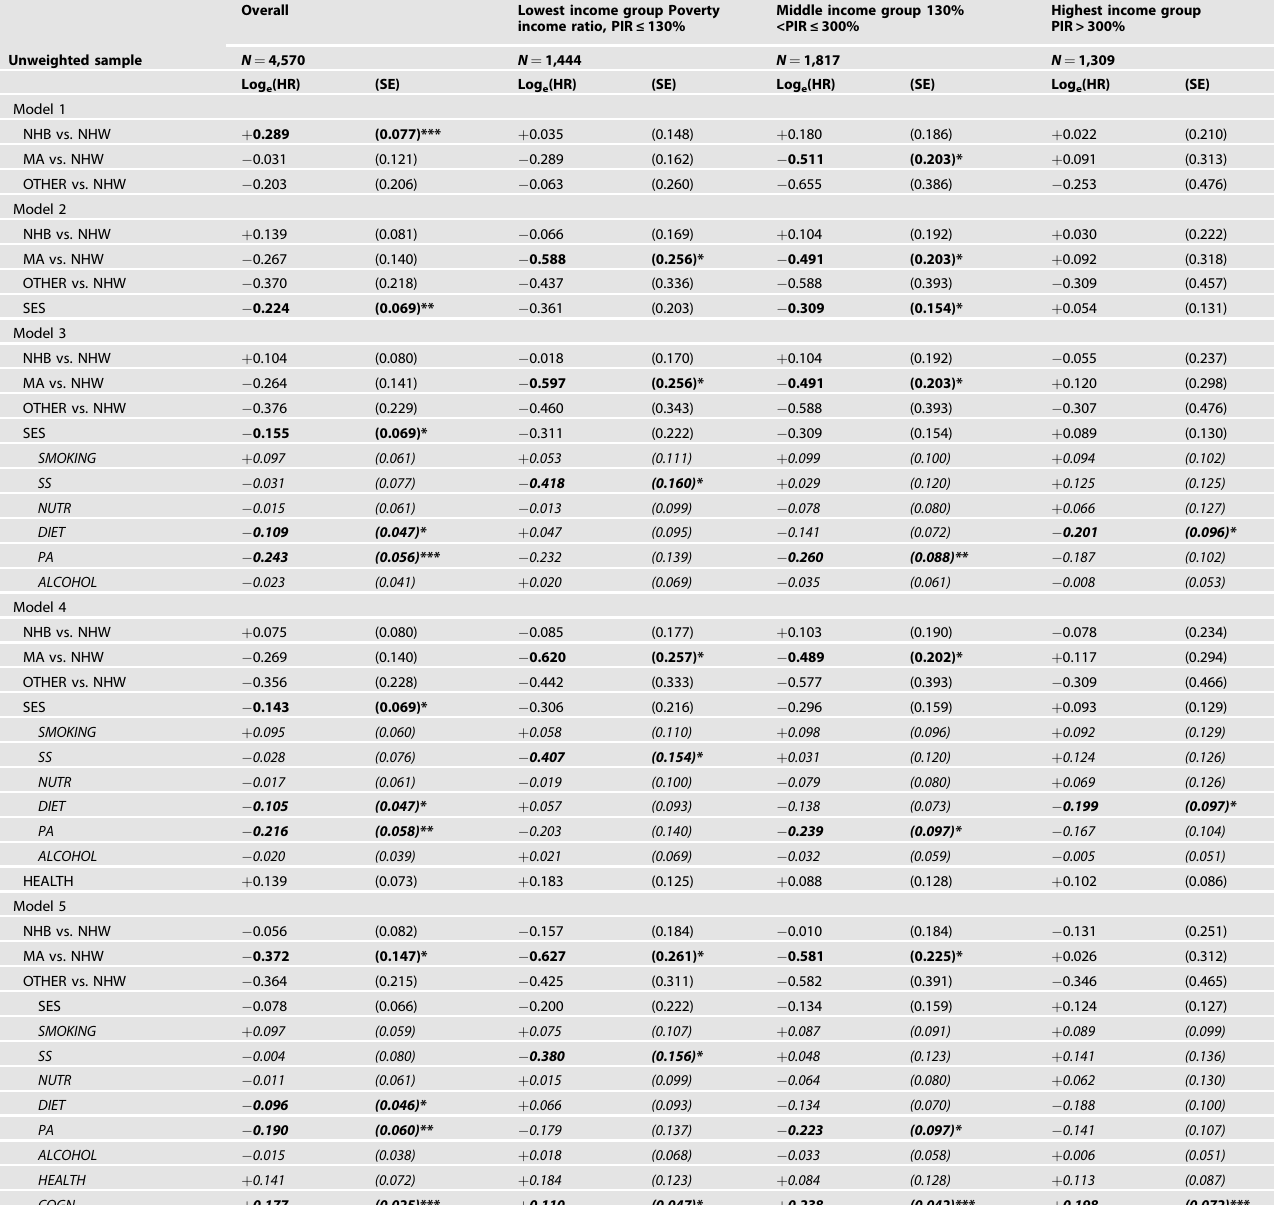
Table 2. Racial/ethnic disparities (NHB and MA vs. NHW) in incident all-cause dementia across income groups ( ≥ 60 y, Unweighted N = 4592; Weighted N = 35,551,773): Cox proportional hazards models; NHANES III, 1988 – 1994 a